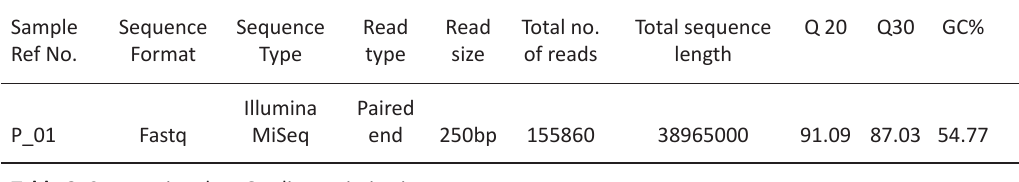
Table 2. Sequencing data Quality optimization